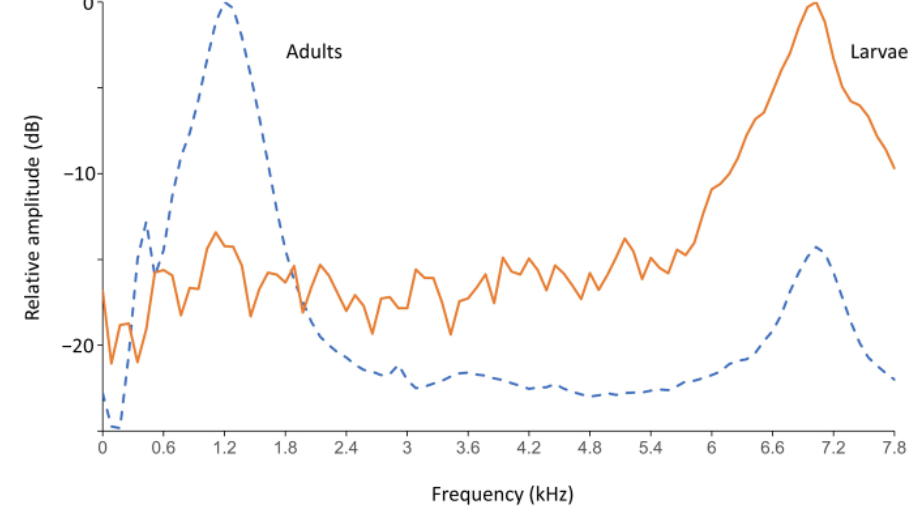
Figure 3. Mean spectral profiles: 10 Sitophilus oryzae adults on grain kernels (dashed line) and larvae figure 180 s record- ings.